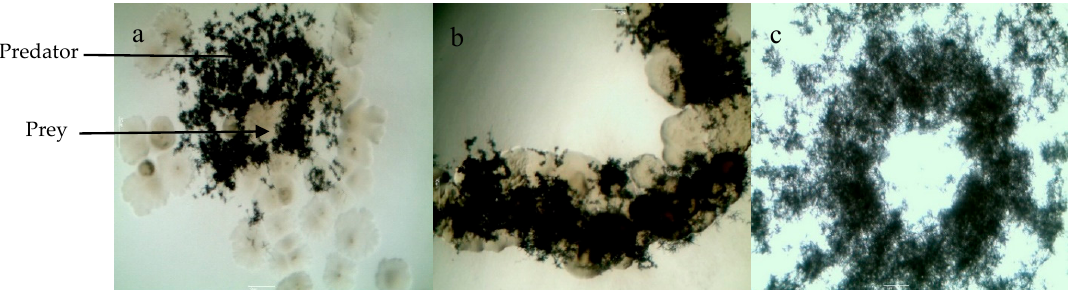
Figure 2. Images of Actinobacteria EMM111 predation of M. luteus . ( a ) and ( b ) Predation of M. luteus by Actinobacteria observed by phase-contrast microscopy at magnitude of 400x; ( c ) total elimination of prey cells after 15 days of incubation. The scale bar is 10 µ